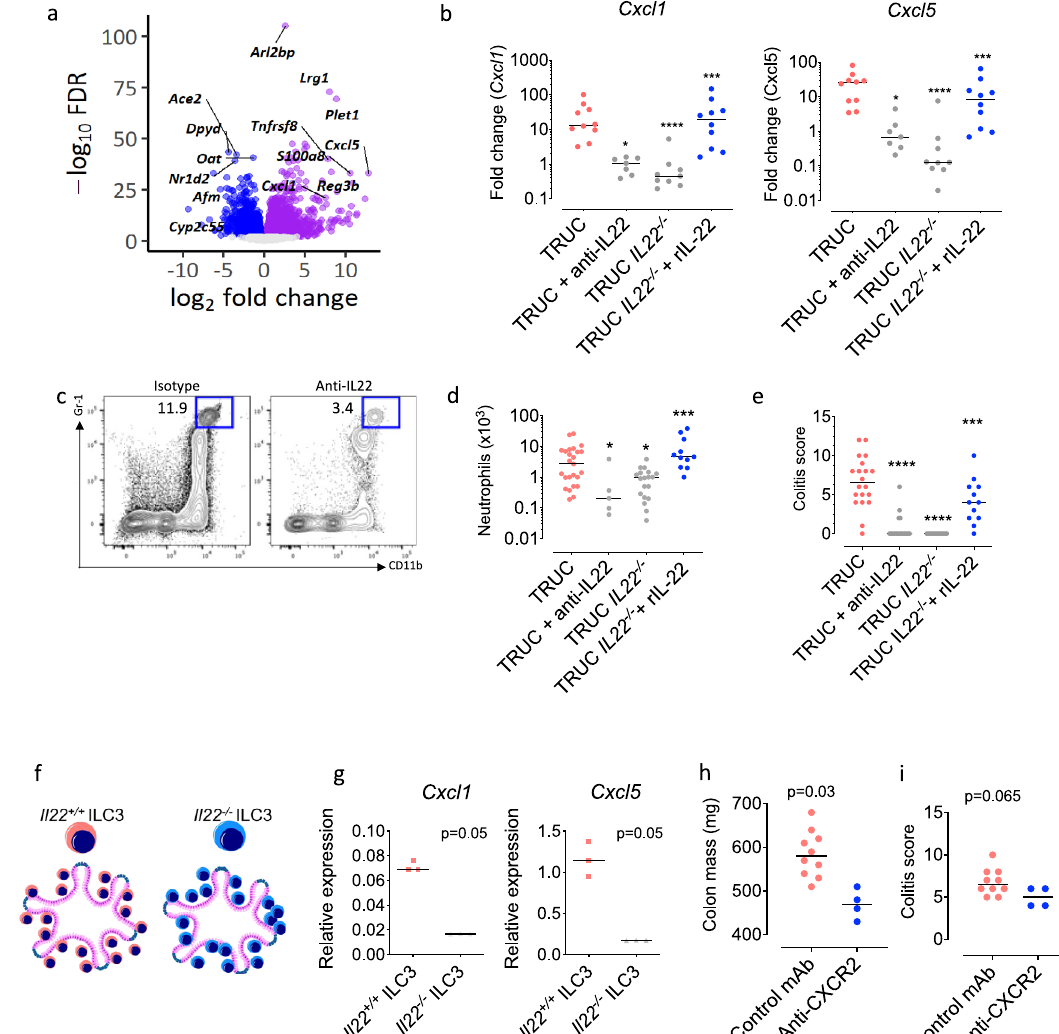
Fig. 6 |IL-22isafunctionally importantregulatorofneutrophilrecruitmentin chronic colitis. a Volcano plot demonstrating fold change and P value of differ- entially expressed genes in TRUC mice vs controls (Rag2 − / − )( n =6, biological repli- cates), b effects of IL-22 neutralization to the expression of neutrophil attracting chemokines Cxcl1 and Cxcl5 ( n =36 biological replicates, Kruskal – Wallis with Dunn ’ s multiple comparison test for TRUC+anti-IL22 and TRUC IL22 − / − vs TRUC, * p <0.05, **** p <0.0001 and Mann – Whitney two tailed test for TRUC IL22 − / − +IL-22 vs . TRUC IL22 − / − , *** p <0.001, line denotesmedian), c fl ow cytometryplot, showing the relative frequency of neutrophils in colonic tissue ofTRUC mice treated with a monoclonal antibody blocking IL-22, d absolute number of neutrophils in mouse colonic tissue of TRUC mice and TRUC mice with IL-22 neutralization (( n =36, biological replicates, Kruskal – Wallis with Dunn ’ s multiple comparison test for TRUC+anti-IL22 and TRUC IL22 − / − vs TRUC, * p <0.05, **** p <0.0001